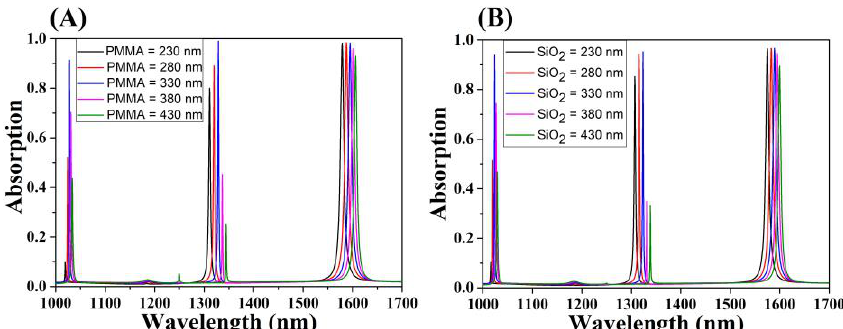
Figure 10. ( A ) Change in the absorption of the PMMA layer with varying incident wavelength. ( B ) Change in the absorption with varying incident wavelength after the PMMA layer was replaced by a SiO 2 layer.